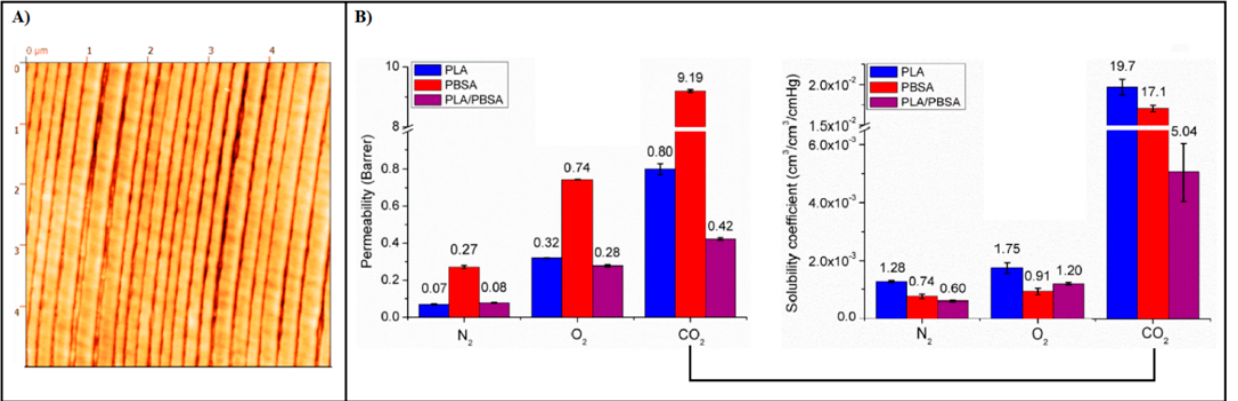
Figure 8. ( A ) AFM images of the multilayer film with PLA in light and PBSA in dark; ( B ) gas permeability and solubility coefficients for the monolayer films of PLA and PBSA and the multilayer film of PLA/PBSA. Adapted from [137] with permission from American Chemical Society. Copyright © 2017.